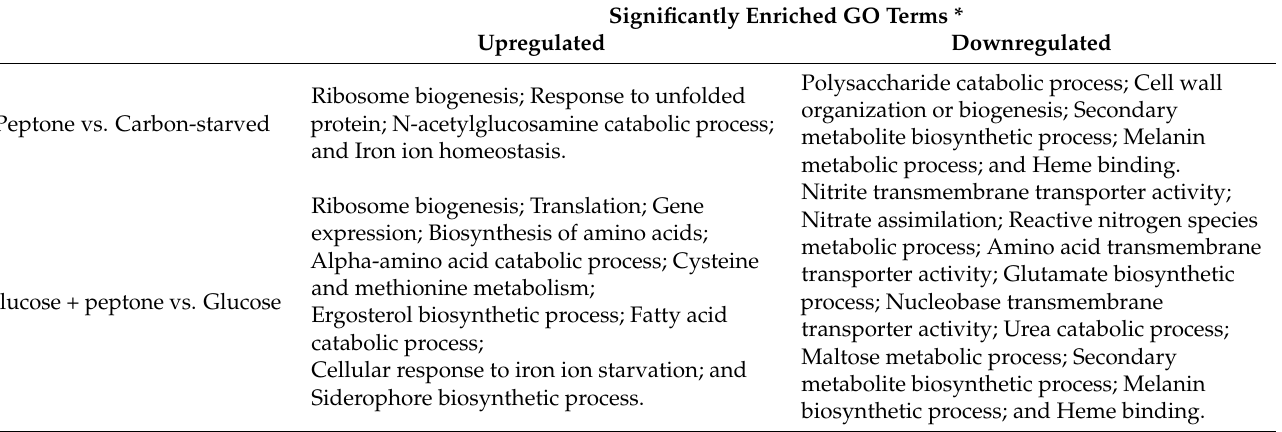
Table 2. GO terms enriched significantly in the upregulated or downregulated gene sets in peptone- containing cultures. Significantly Enriched GO Terms * Upregulated Downregulated